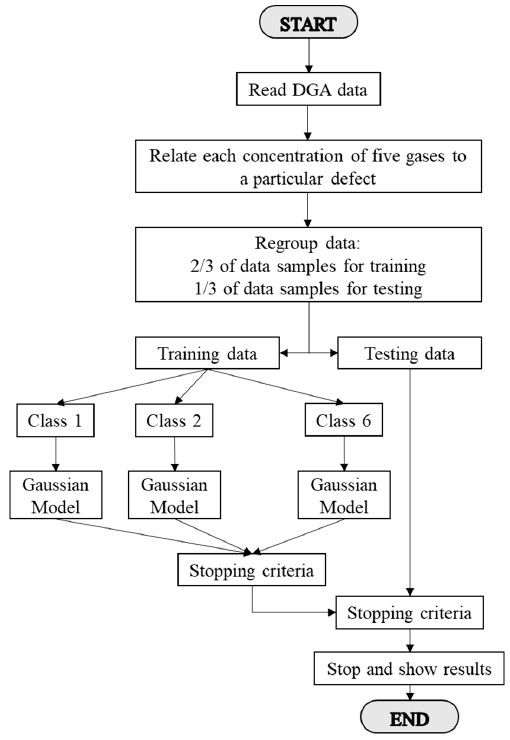
Figure 3. Flowchart formulating the problem using Gaussian classifier.